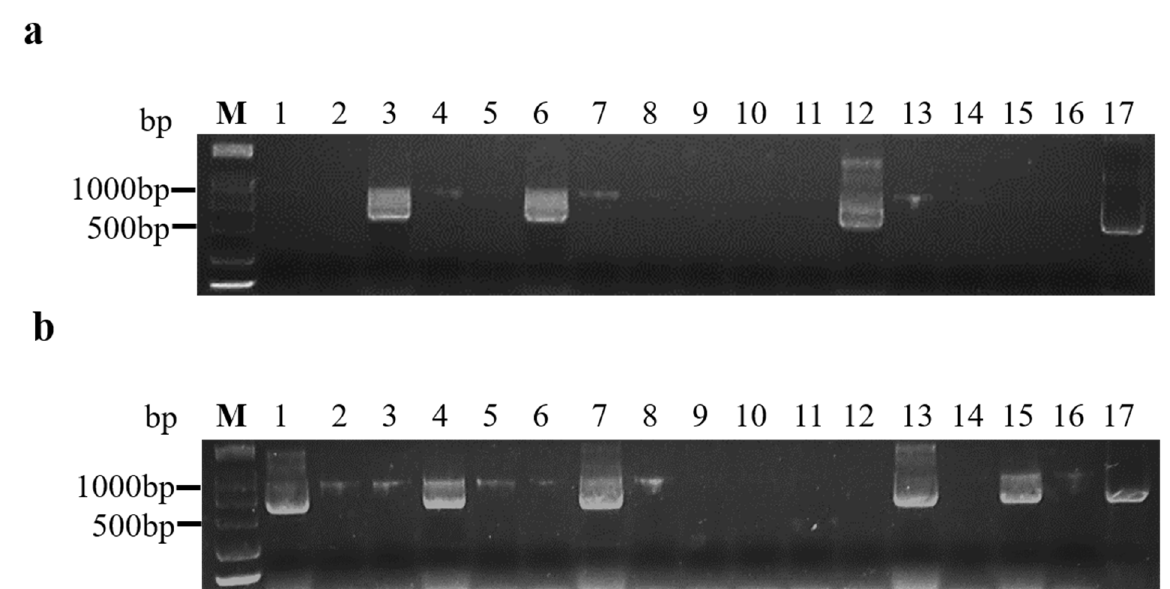
Figure 1. Agarose gel analysis of RT-PCR products using BrYV primers from A. thaliana plants inoculated by aphids. ( a ) Aphids that acquired the virus from frozen infected leaves; ( b ) aphids that acquired the virus from transgenic A. thaliana line 412 leaves. M: Marker (DCL 2000, Tsingke, Beijing, China); lines 1–16: aphids inoculated through A. thaliana ; line 17: positive control.